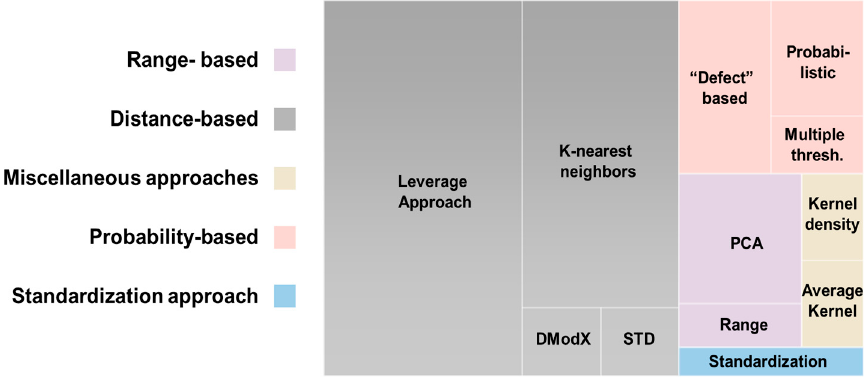
Figure 5. Methods determining the applicability domain of a model.